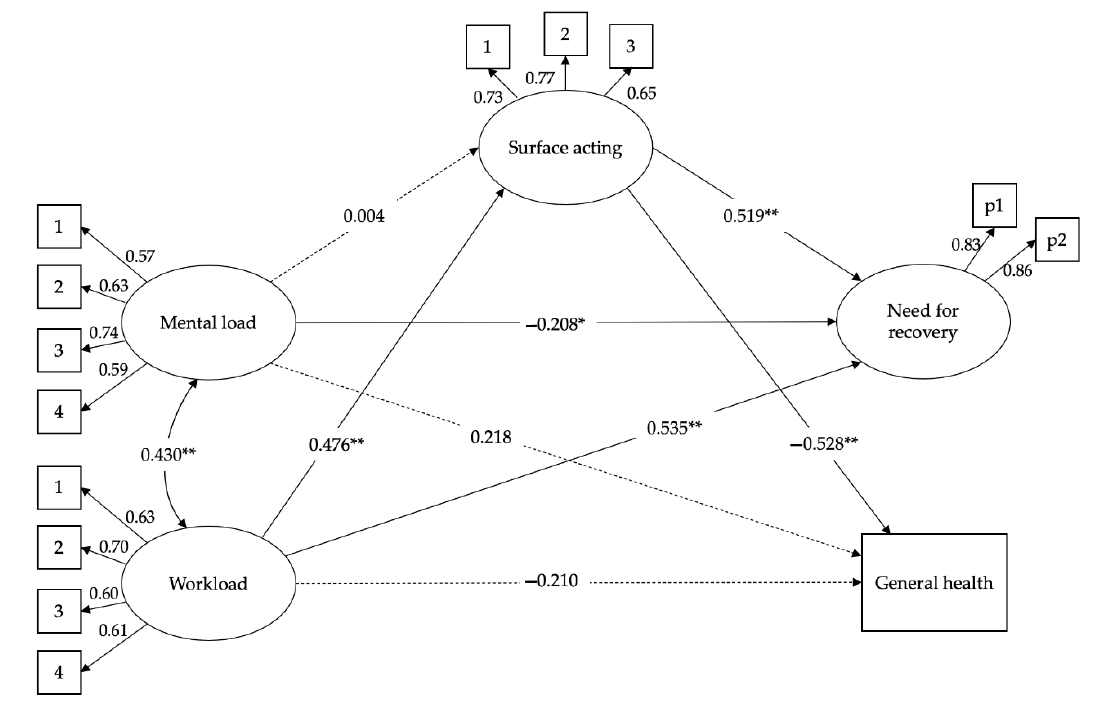
Figure 1. The structural model for the back-office sample ( N = 436). * p < 0.05 **, p < 0.01.